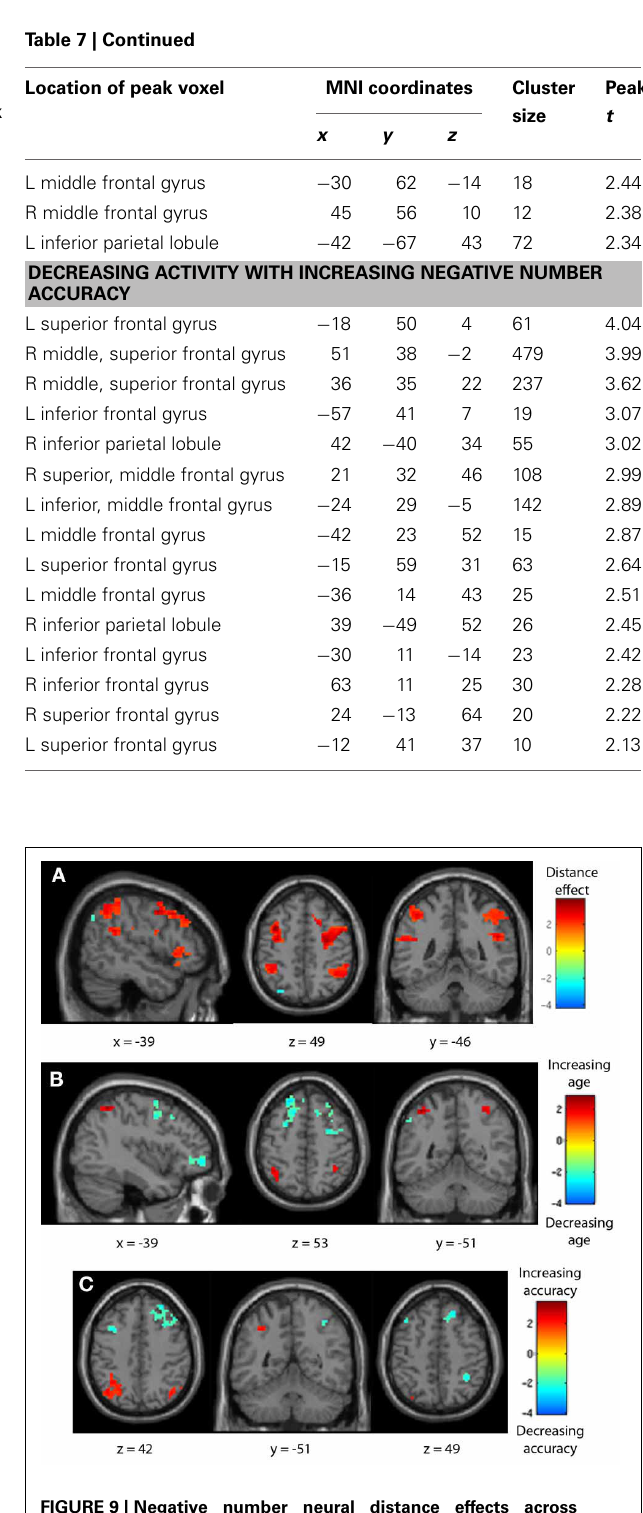
FIGURE 9 | Negative number neural distance effects across children. Fifth- and seventh-graders together demonstrated a bilateral IPS distance effect for negative number comparisons. (A) A frontoparietal shift was seen with increasing age (B) , and a right-to-left laterality shift was seen in the IPS with increasing negative comparison accuracy (C)